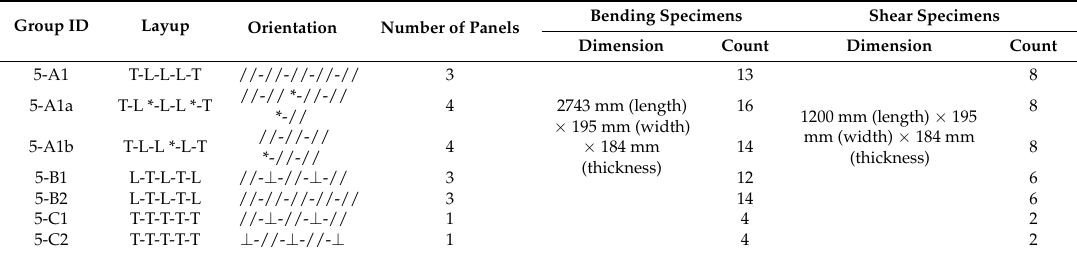
Table 2. Layup information of the panels and number of specimens for mechanical